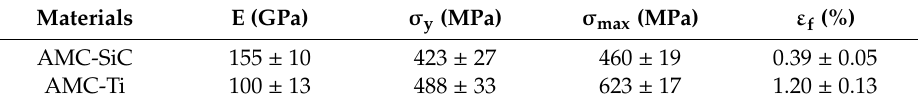
Figure 9. Engineering stress–strain curves of the prepared composites and the matrix. Table 3. Tensile properties of the prepared composites in as-casting.